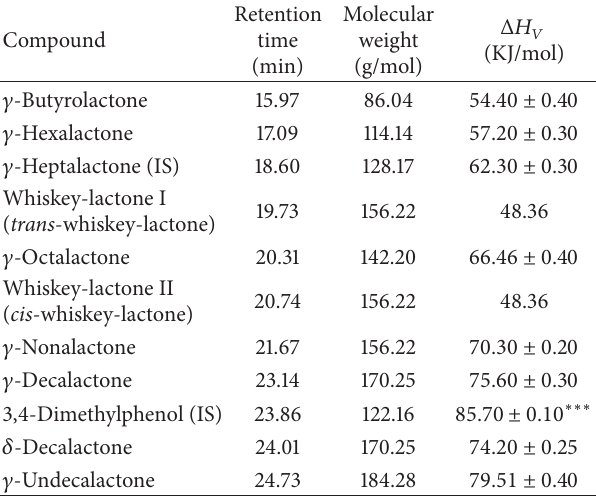
Table 2: Retention time, molecular weight and enthalpy of vapor- ization [31,